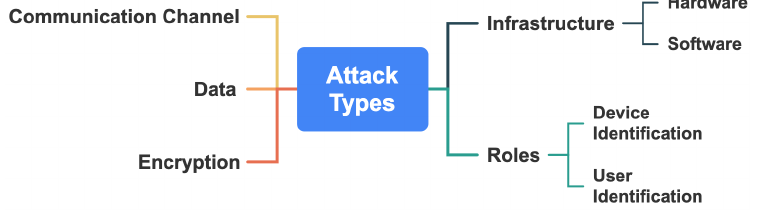
Figure 3. Types of attacks, adapted from